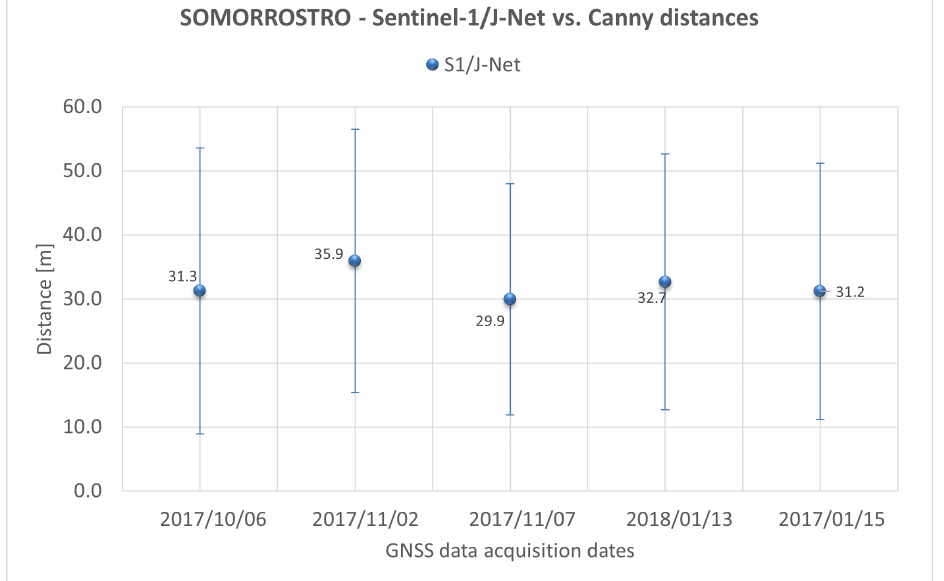
Figure A4. Comparison between the mean distance and standard deviation for each date on Sentinel-1 imagery considering J-Net Dynamic and Canny algorithms in Somorrostro.